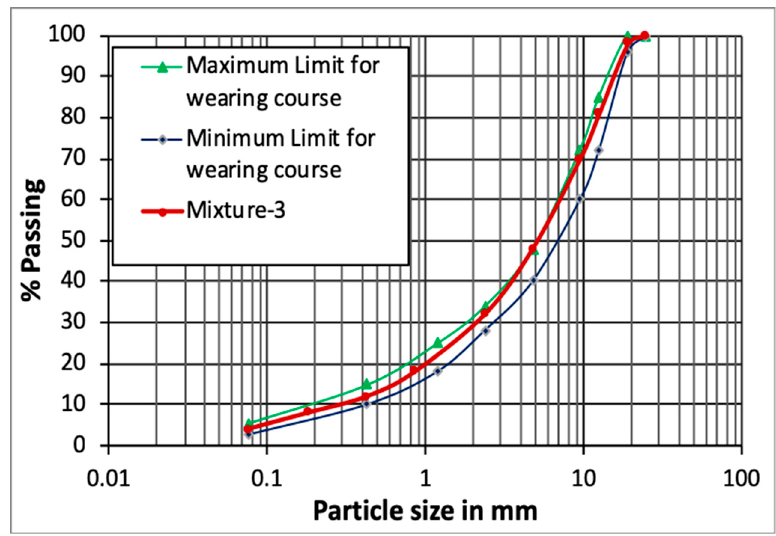
Figure 4. Gradation of wearing coarse field loose mixture (mixture 3).